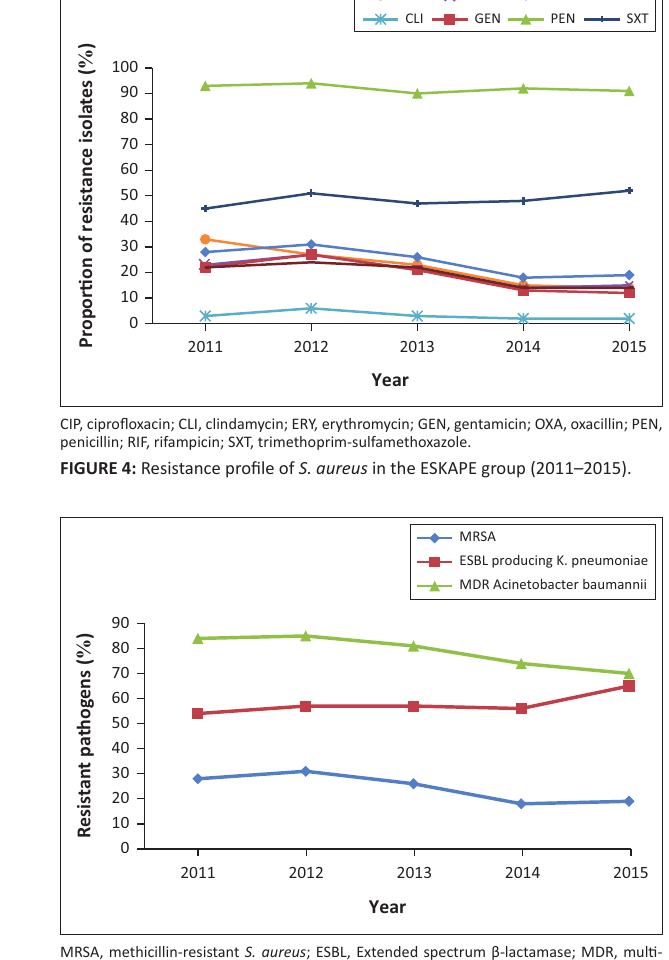
FIGURE 5: Distribution of highly resistant ESKAPE pathogens (2011–2015).